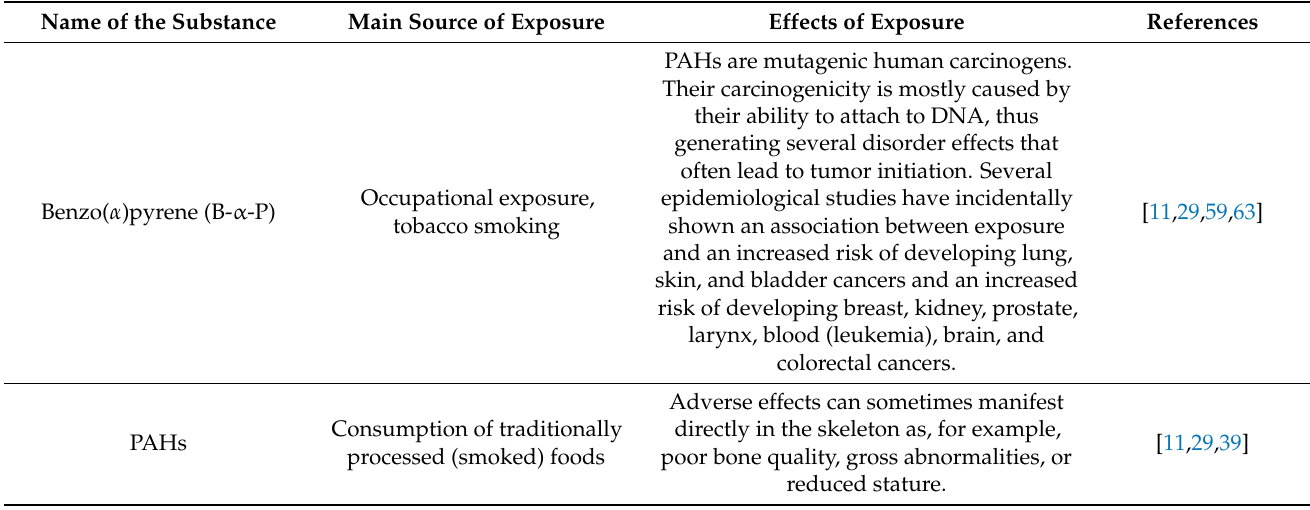
Table 6. Impact of selected PAHs on human